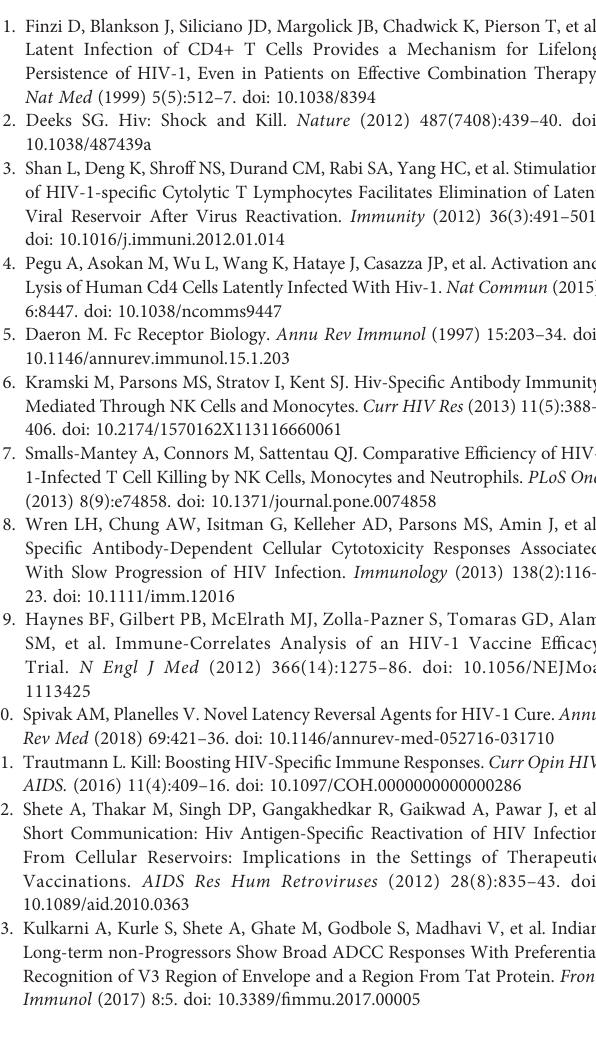
Supplementary Figure 1 | Gating Strategy for fl ow based assay using ACH2 cell line (1) . The lymphocytes were gated based on FSC/SSC scatter (2) . The NK cells were then identi fi ed as CD3 − CD56+ cells (3) .The ACH2 cells were identi fi ed as CD3 − cells as they do not express CD4 and CD8 markers and (4) assessed for intracellular P24 expression. Supplementary Figure 2 | Gating Strategy for fl ow based assay using HIV ENV C-activated HIV Infected CD4+ T cells. (A) The FACS dot plot shows the gating strategy for CD4+ cells and NK cell (1) . The lymphocytes were gated on the basis of forward and side scatter (2) . CD3 − CD56 dim+ cells gated as NK cells and further assessed for secretion of CD107a and IFN g secretion (3) . CD3+CD8 − cells were gated as CD4+ cells and drilled down further to determine the intracellular p24 expression using fl uorescence minus one (FMO) for p24 as control (4) . Supplementary Figure 3 | Gating Strategy for fl ow based assay using Resting Memory CD4+ Cells (1) . The lymphocytes were gated on the basis of forward and side scatter. Next (2) CD4 − CD8 − cells were gated effector NK cells and collected in one tube, and CD4+CD8 − cells were gated as CD4 cells. These CD4+ cells were drilled down for sorting CD45RO+CD4+ cells using (3) fl uorescence minus one (FMO) for CD45RO as control and (4) collected in the second